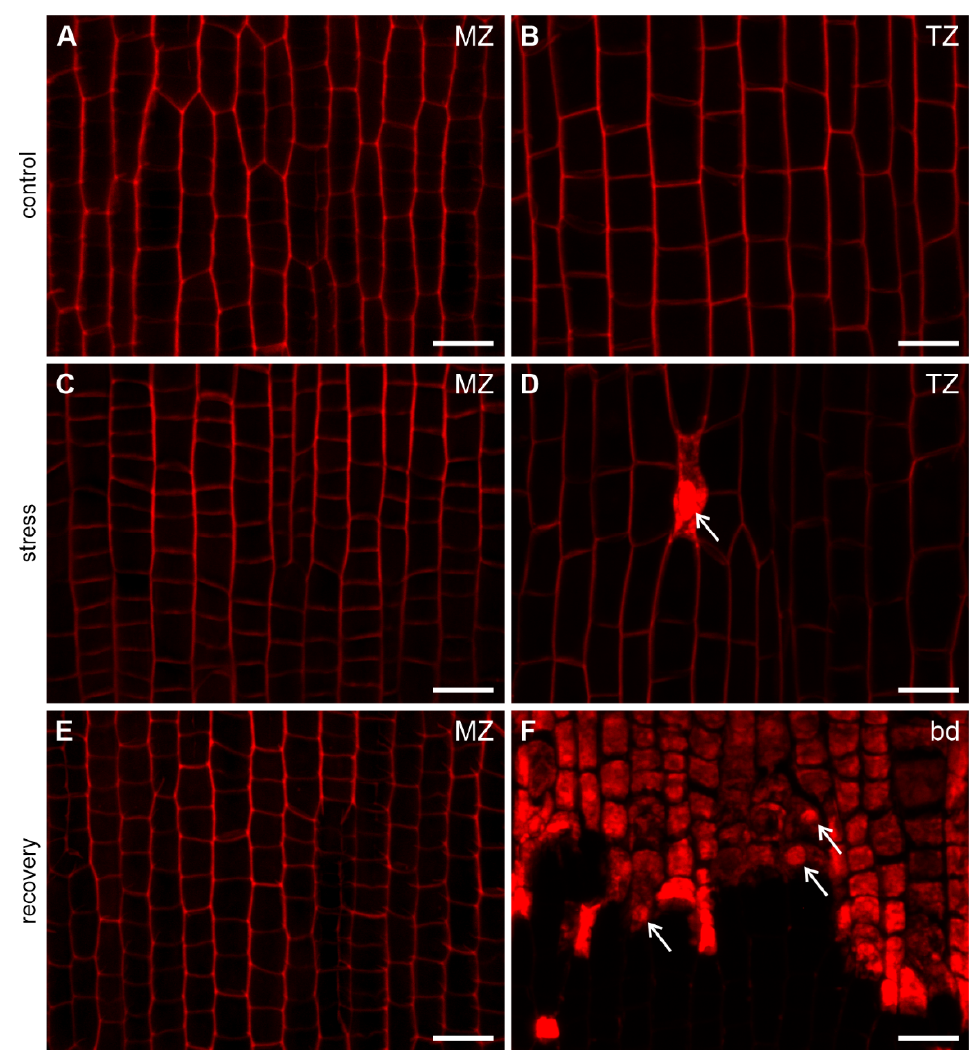
Figure 6. Viability detection of protodermal ( A , C , E ) and young epidermal ( B , D , F ) cells with pro- pidium iodide. In the meristematic zone of C, S and R roots ( A , C , E , respectively) and in the transition zone of C roots ( B ) all cells are viable (only cell walls stained). In the transition zone of S roots ( D ) rarely distributed single cells are dead (cytoplasm and nuclei stained, arrow). In the boundary region of R roots ( F ) all cells above the boundary are dead with cytoplasm and nuclei (arrows) stained, while cells below the boundary are alive, although their walls are not visible due to reduced laser power to avoid oversaturated pixels resulting from the very strong signal in cells above the boundary. MZ meristematic zone, TZ transition zone, bd boundary between differentially stained regions in R roots. Scale bars: 20 μm.